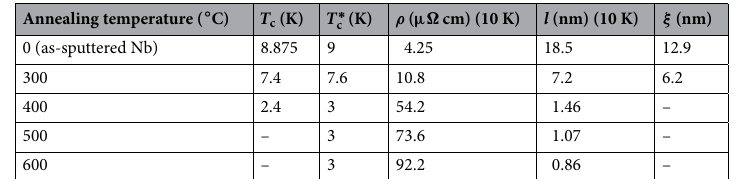
Table 1. Summary of the parameters measured from the as-sputtered Nb film and the annealed samples.